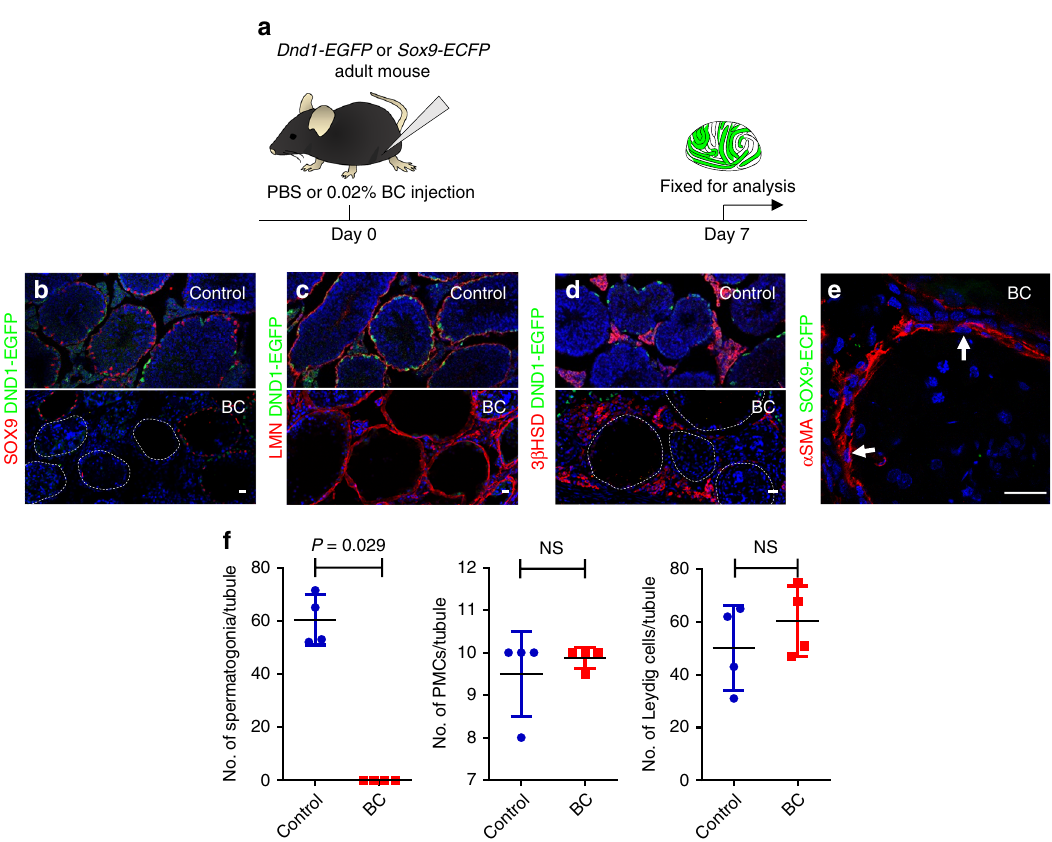
Fig. 4 Spermatogonia were also lost by 7 days after BC treatment, but Leydig and PMCs were intact. a Schematic representation of experimental procedures for in vivo adult germ and Sertoli cell ablation. b – d DND1-EGFP (green; and see Supplementary Fig. 7) labels spermatogonia, co-labeled with antibodies against b SOX9 (red), c LMN (red), d 3 β HSD (red). e SOX9-ECFP (green) and α SMA (red). Hoechst (blue). Ten independent experiments. Scale bar: 25 µ m. f Quanti fi cation of spermatogonia, Leydig cells, and PMCs 7 days after 0.02% BC treatment. Data were analyzed from four biologically independent samples examined over three independent experiments and expressed as mean ± SD; (NS) not signi fi cant. Statistical analysis was performed using an unpaired t test, Kolmogorov – Smirnov